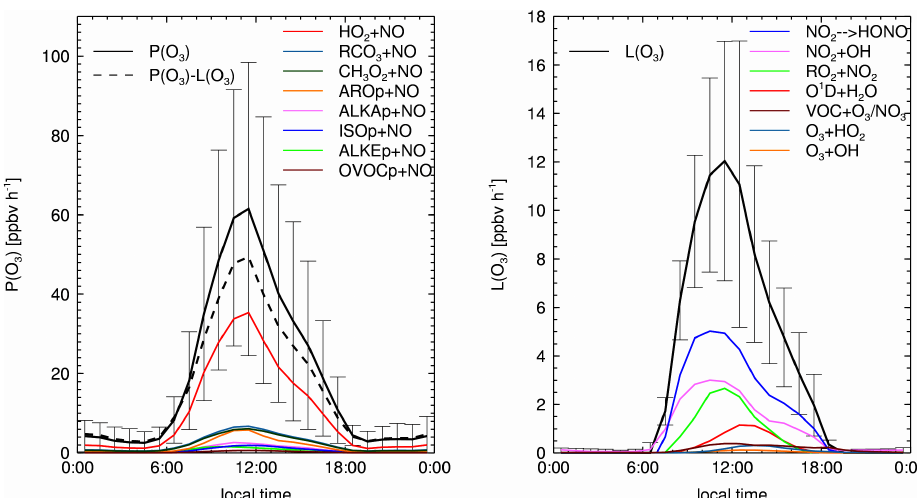
Fig. 5. Average diurnal profiles and breakdowns of O 3 production (left) and loss rates (ppbvh − 1 ) (right). The vertical bars show the standard deviation.